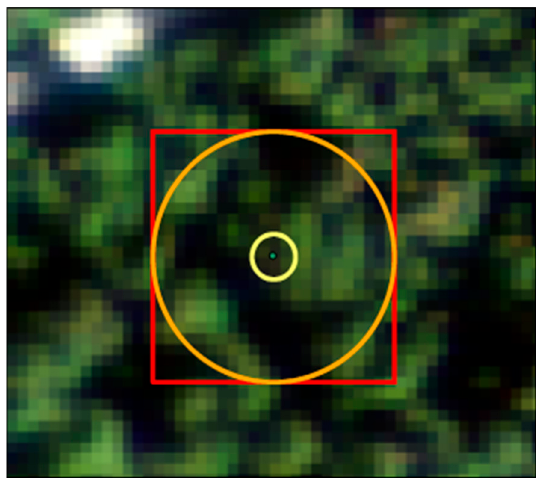
Figure 2. Composition and structure of common stand exam plot design, with outer circle (orange) representing a 0.04 hectare plot for trees greater than or equal to 12.7 cm diameter at breast height (radius = 11.4 m) and inner circle (yellow) representing a 0.0013 ha plot for trees less than 12.7 cm DBH (radius = 2 m). The outer square represents the area summarized for the NAIP imagery and LiDAR data.